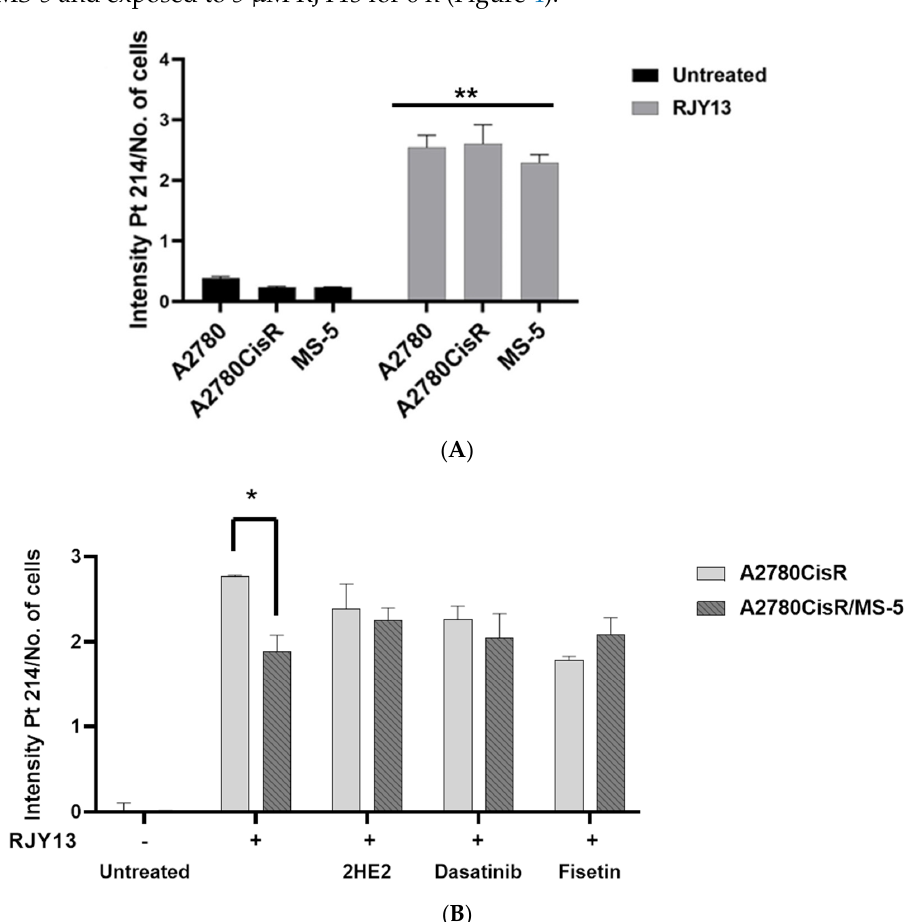
Figure 4. Platinum intracellular concentration in OC cells. A2780CisR, A2780, and MS-5 cells were exposed to RJY13 (5 µ M) for 6 h as described in materials and methods. Cells were collected, mineralized with 65% HNO3, and then completely dried. Dry platinum-containing material was measured at m / z 214 by an ICP-OES instrument (Agilent Technologies, Santa Clara, CA, USA). ( A ). Cells growing as monolayers were exposed to RJY13 and levels of platinum were measured. ( B ). A2780cisR grown as monolayers or in direct co-culture with MS-5 were exposed to RJY13 in combination with 2HE2 (10 µ M), dasatinib (5 µ M), or fisetin (10 µ M). * p < 0.05 and ** p <